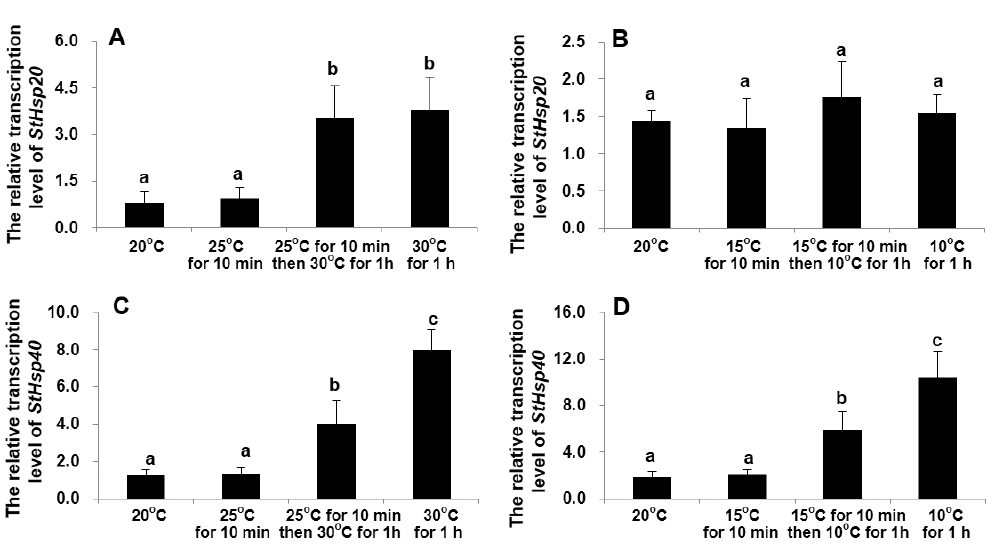
Figure 5. Transcription profiles of StHsp20 ( A , B ) and StHsp40 ( C , D ) in cultures exposed to one-step or stepwise temperature stress (+10 °C ( A , C ); − 10 °C ( B , D ). Different letters show significant differences ( p < 0.05). Error bars represent the standard deviation from 3 replicates.